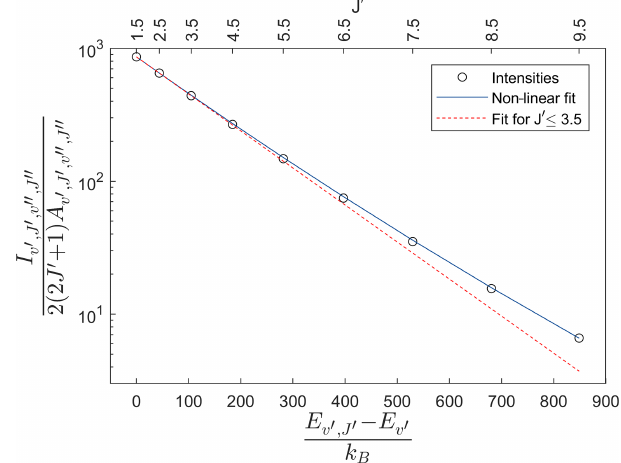
Figure 4. Population of P-branch lines of the (7,4) Meinel band as calculated with an atmospheric background profile containing the wave shown in Fig. 3. The energies given on the x axis are relative to the lowest rotational energy. An exponential fit to the lowest three rotational levels (dashed red line) underestimates the populations at higher levels. A non-linear fit as presented in Eq. (10) can fit the in- tensities of rotational levels as high as J (cid:48) = 9 . 5, while reproducing the same temperature as the fit to the lowest three